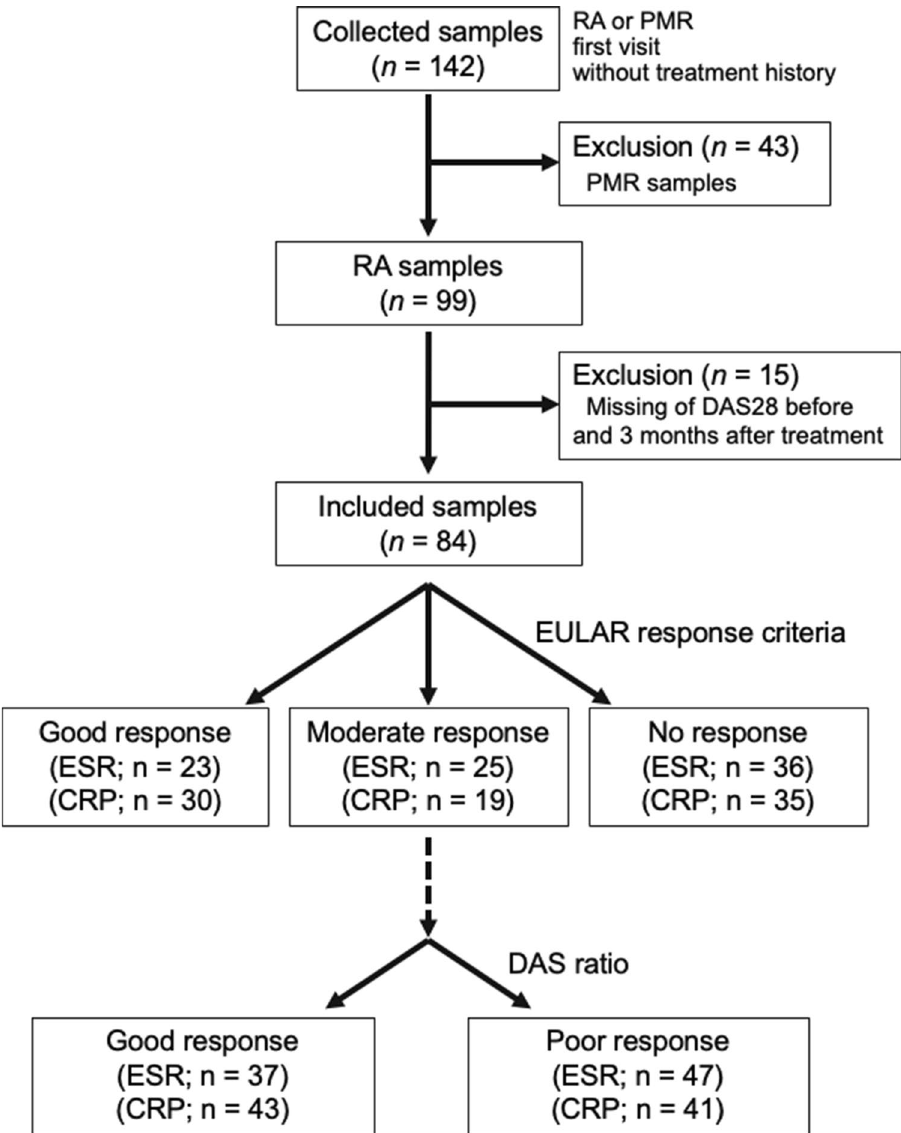
Figure 1. Flow chart of analyzed RA samples based on therapeutic response. Serum IgG antibody titers were classified according to the therapeutic response of RA into two groups and analyzed. After 3 months of treatment, the patients were grouped according to the EULAR response criteria (good, moderate, no response) and the DAS ratio (good and poor response) using DAS28-ESR and DAS28-CRP. CRP C-reactive protein, DAS28 disease activity score 28, ESR erythrocyte sedimentation rate, EULAR European Alliance of Associations for Rheumatology, IgG immunoglobulin G, RA rheumatoid